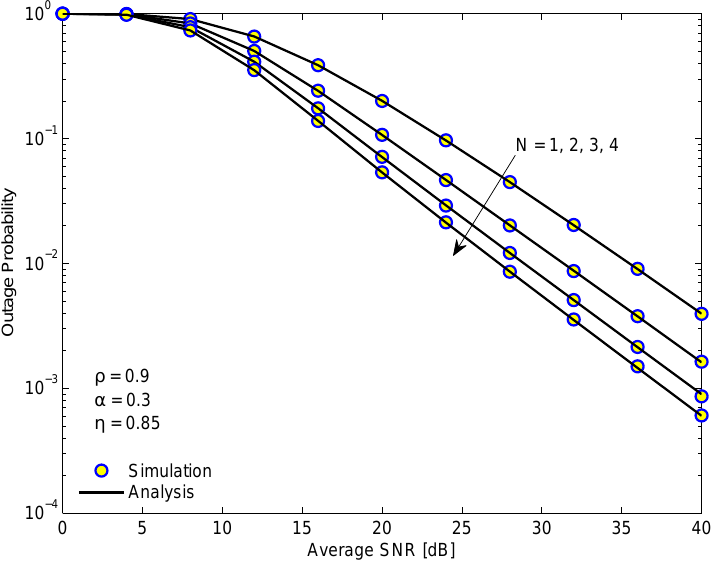
Figure 4. The outage probability of D 1 in the EH-NOMA relaying system versus the average SINR for different numbers of